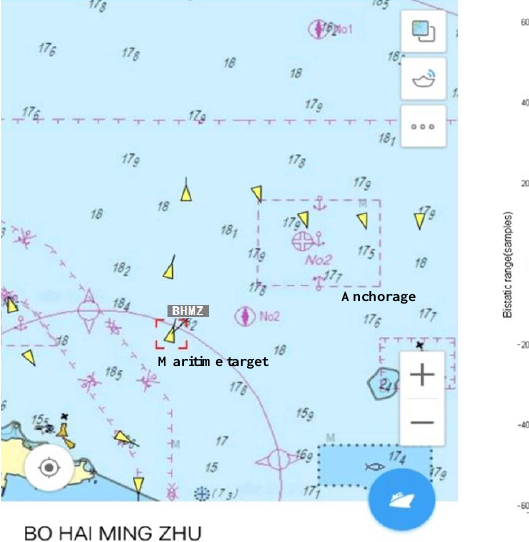
( b ) Figure 18. Comparison of the results between the AIS map and HBR map of maritime targets (T2 time: 10:45:02, range: 29.25 km): ( a ) AIS map; ( b ) HBR map. ( a ) ( b ) Figure 19. Photos of the target — BO HAI MING ZHU: ( a ) Docked in the port; ( b ) Leaving the port.